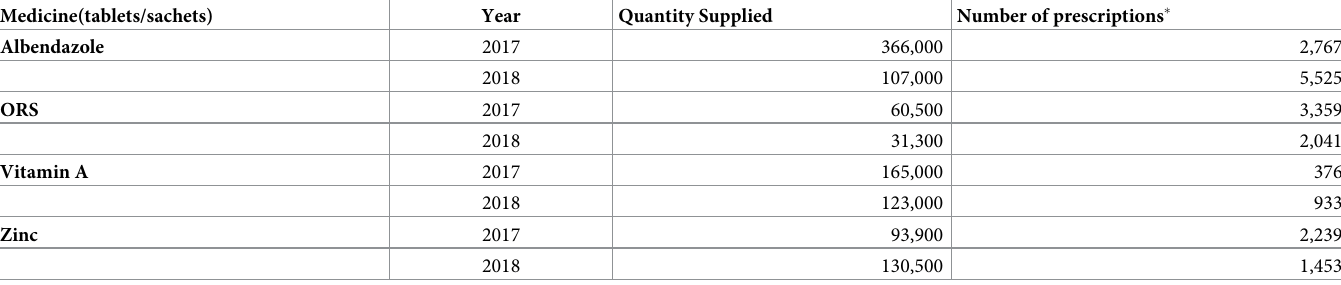
Units of the drugs used at the facilities were—Zn 20mg, Albendazole 200/400mg, Vitamin A 100,000 IU. � Prescriptions per person.